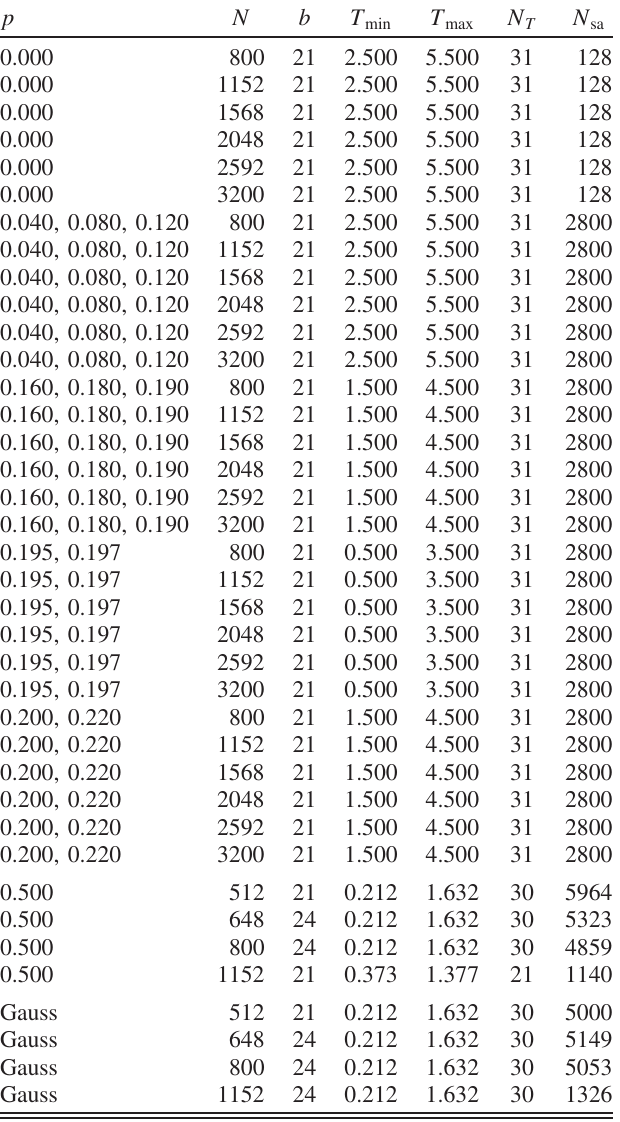
TABLE I. Simulation parameters: For each number of spins N and fraction of ferromagnetic bonds p , we equilibrate and measure for 2 b Monte Carlo sweeps. T [ T ] is the lowest min max [highest] temperature, and N is the number of temperatures. N T sa is the number of disorder samples. The bottom block labeled with “ Gauss ” lists the simulation parameters for the pure spin glass with Gaussian disorder. The numbers for the pure spin glass with bimodal disorder are labeled with “ p ¼ 0 . 500 . ”